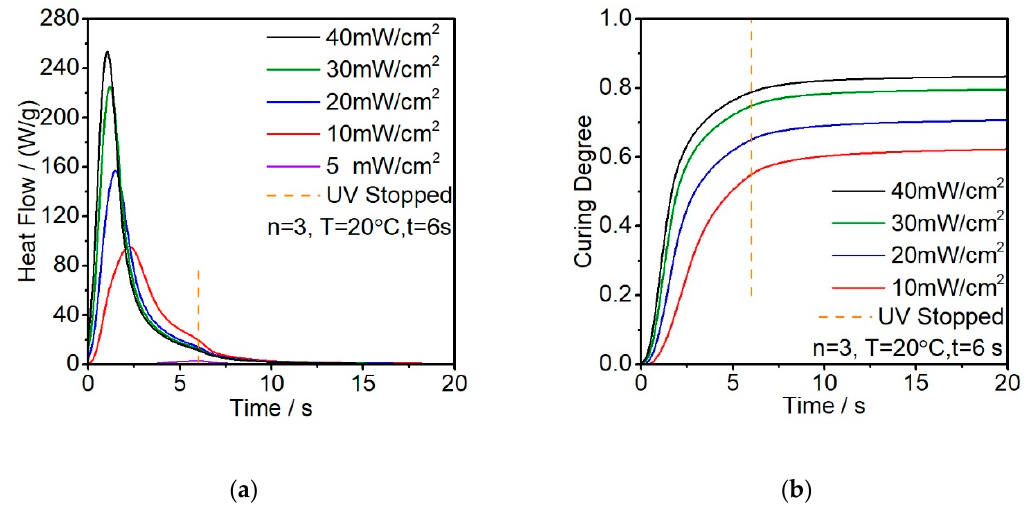
Figure 5. ( a ) Enthalpy analysis with different light intensities; ( b ) calculated curing degree in function with the light intensities.